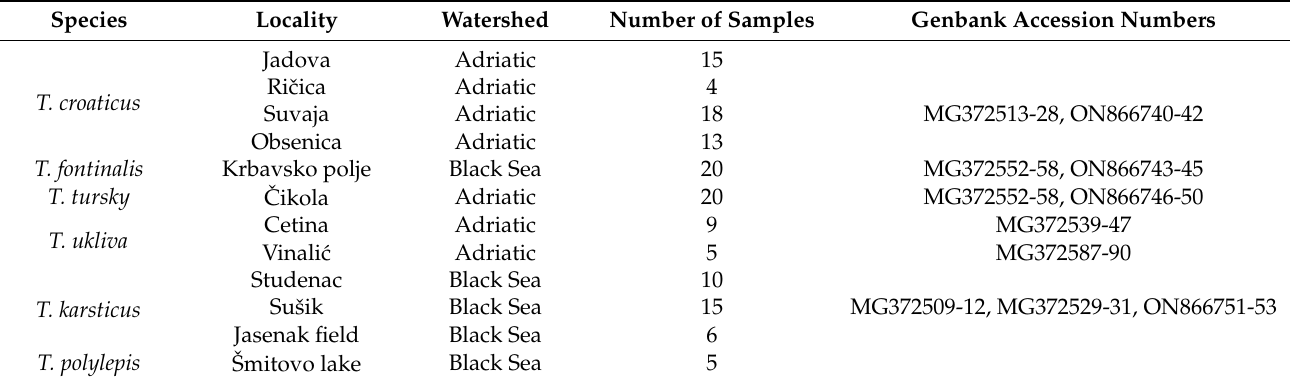
Table 1. Number of samples obtained from each locality and for each species, as well as accession numbers of the haplotypes deposited in the GenBank (which will be added in the proof; however, alignment can be sent to the Editor, if